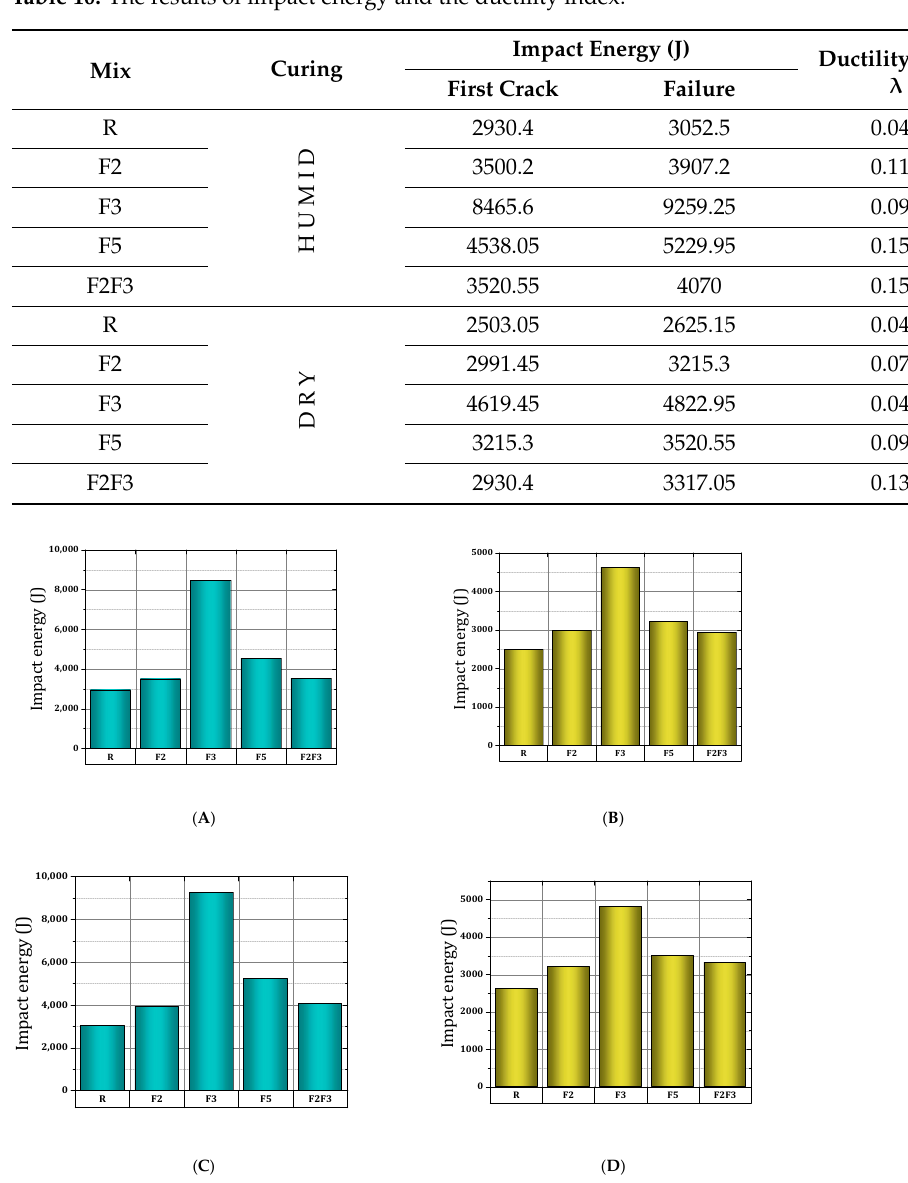
Figure 29. Impact energy results for first crack (( A ): humid, ( B ): dry) and failure strength (( C ): humid, ( D ): dry).